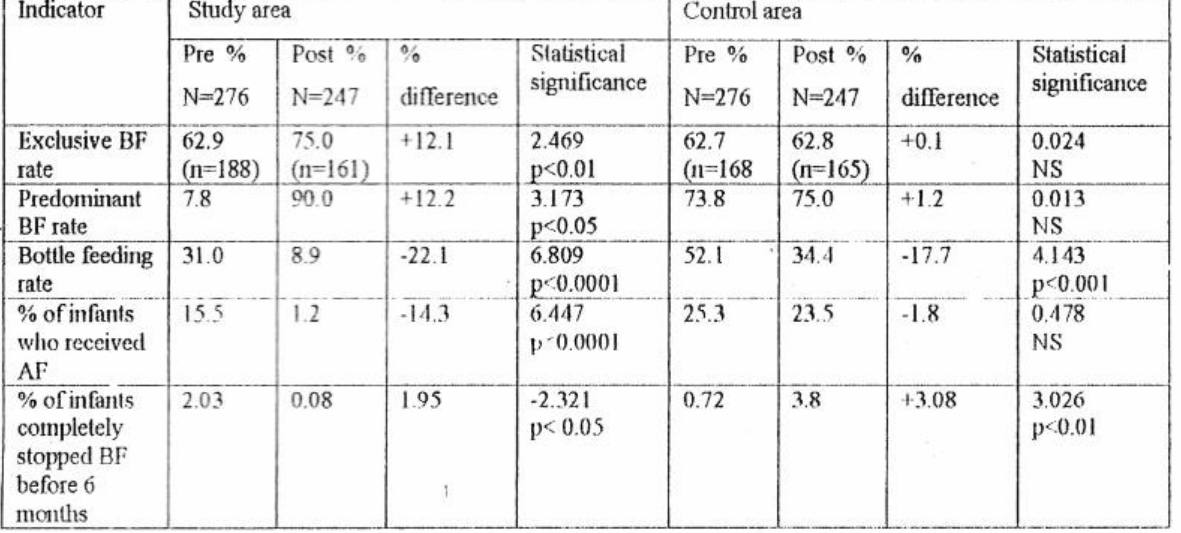
‘Table |: Percentage change in infant feeding practices in the study and control areas ~ pre and post intervention Indicator